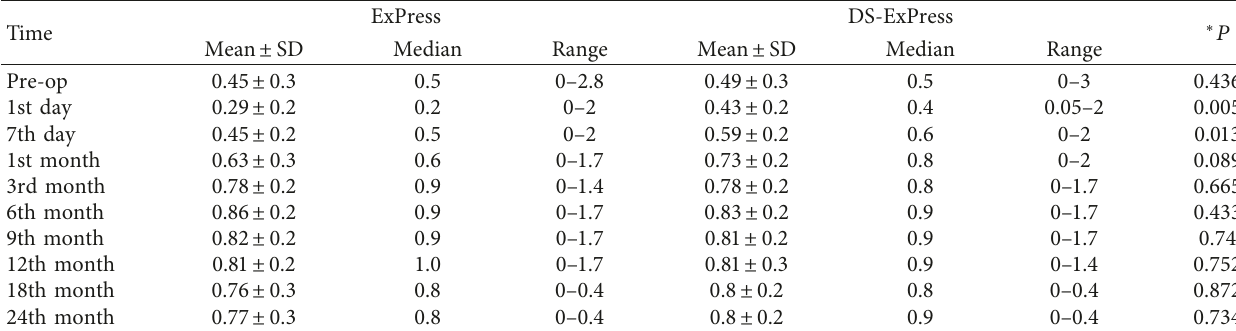
Table 6: Visual acuity (Snellen charts): mean values, median values, standard deviations, and range in the ExPress and DS-ExPress groups at specific times after